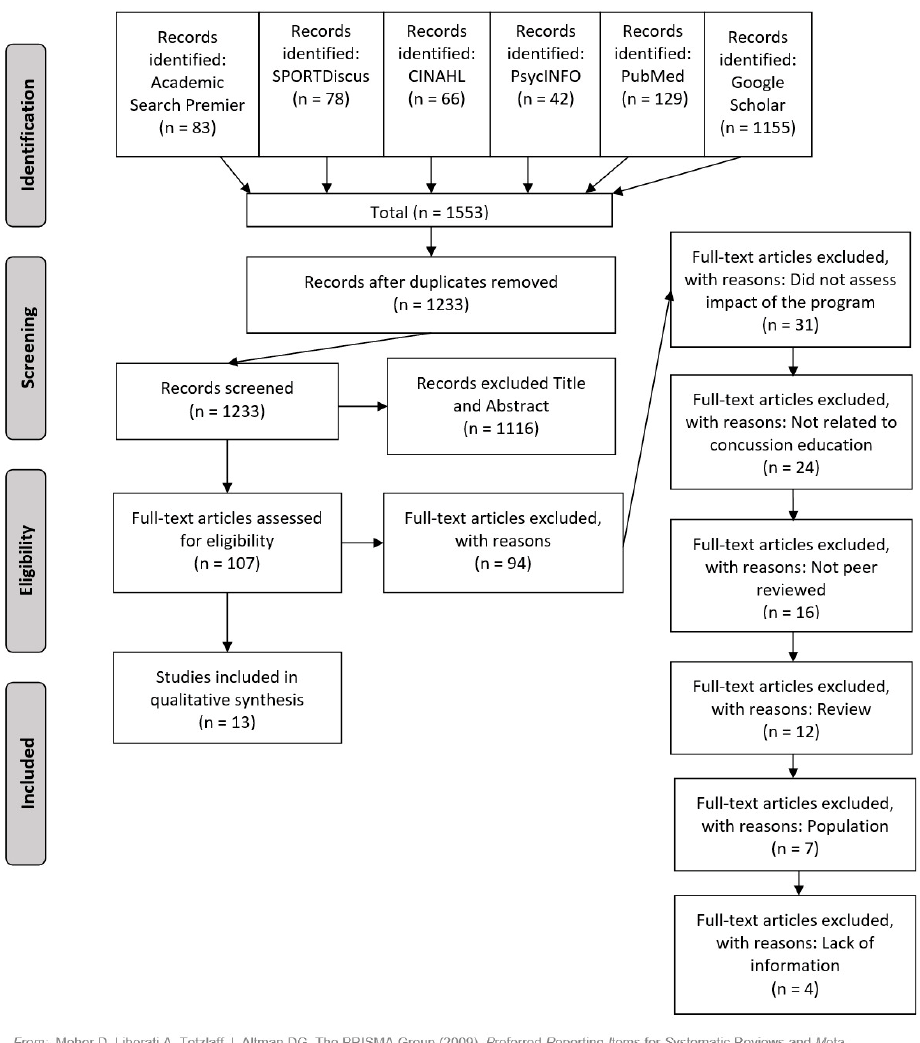
Figure 1. The PRISMA flowchart of the article selection process.